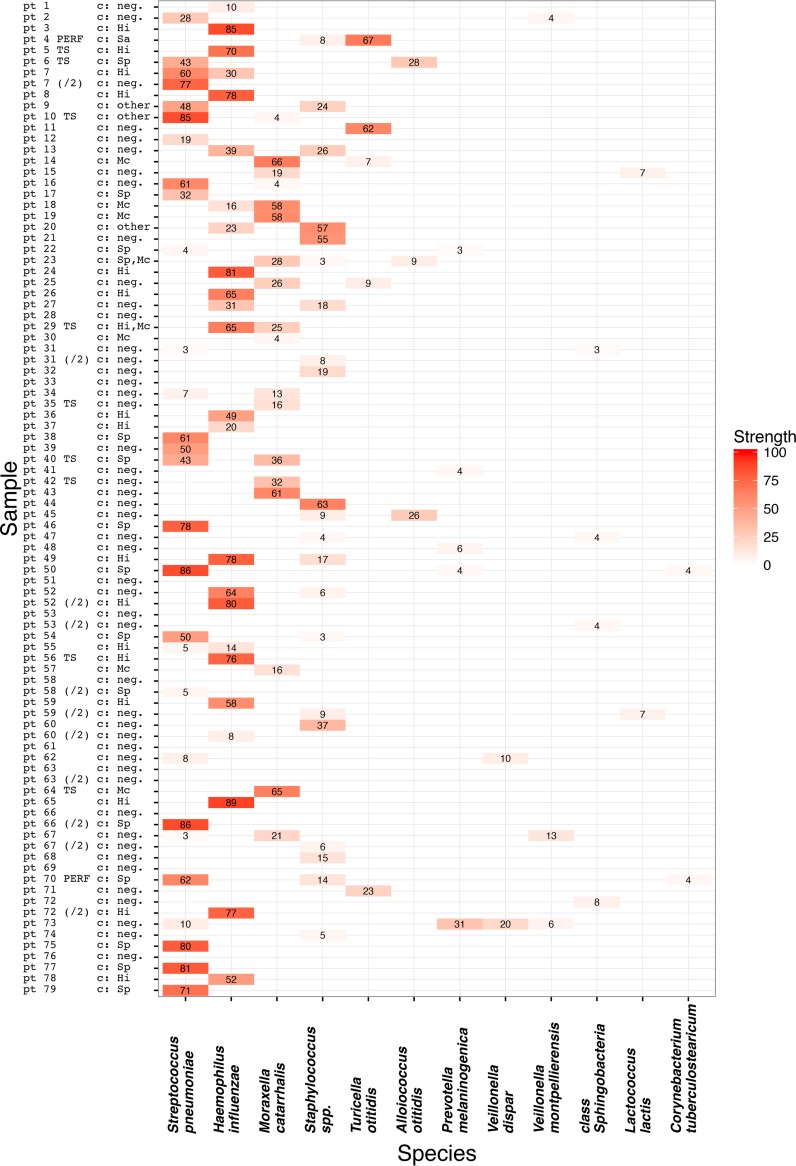
Bacteria found in AOM samples and strengths of their signals. The vertical axis shows individual samples: /2, second sample from the subject; PERF, sample from perforation; TS, sample from tympanostomy tube; other samples are from myringotomy; c, culture; neg., culture negative; Sp, S. pneumoniae; Hi, H. influenzae; Mc, M. catarrhalis; Sa, Staphylococcus aureus; other, other bacteria. The horizontal axis shows the nine most abundant species or genera that exceeded 3% of the total sample sequencing signal in at least two AOM samples. The intersections are the relative abundances of the total sequencing signal as percentages (rounded to the nearest integer). Taxa comprising <3% of the total sample sequencing signal were disregarded. The assignation of species by 16S rRNA gene profiling is simplified, since the 16S profiling of the V4 region could not distinguish between closely related species in several instances, as follows. (i) S. pneumoniae and the less frequent S. pseudopneumoniae; the latter is commonly (mis)identified as S. pneumoniae by clinical microbiology laboratories worldwide. The sequence of the profiled V4 region of the 16S rRNA gene is also closely related to those of several other streptococci. (ii) H. influenzae and the less frequent H. haemolyticus; the latter could be excluded in culture-positive cases by its beta hemolysis. (iii) M. catarrhalis and the less frequent Moraxella nonliquefaciens; the two could be differentiated only by classic microbiological techniques, including differences in typical antibiograms. Finally, (iv) the 16S profiles in the V4 region are identical in many Staphylococci; please see the text for methods that disentangled the signals.